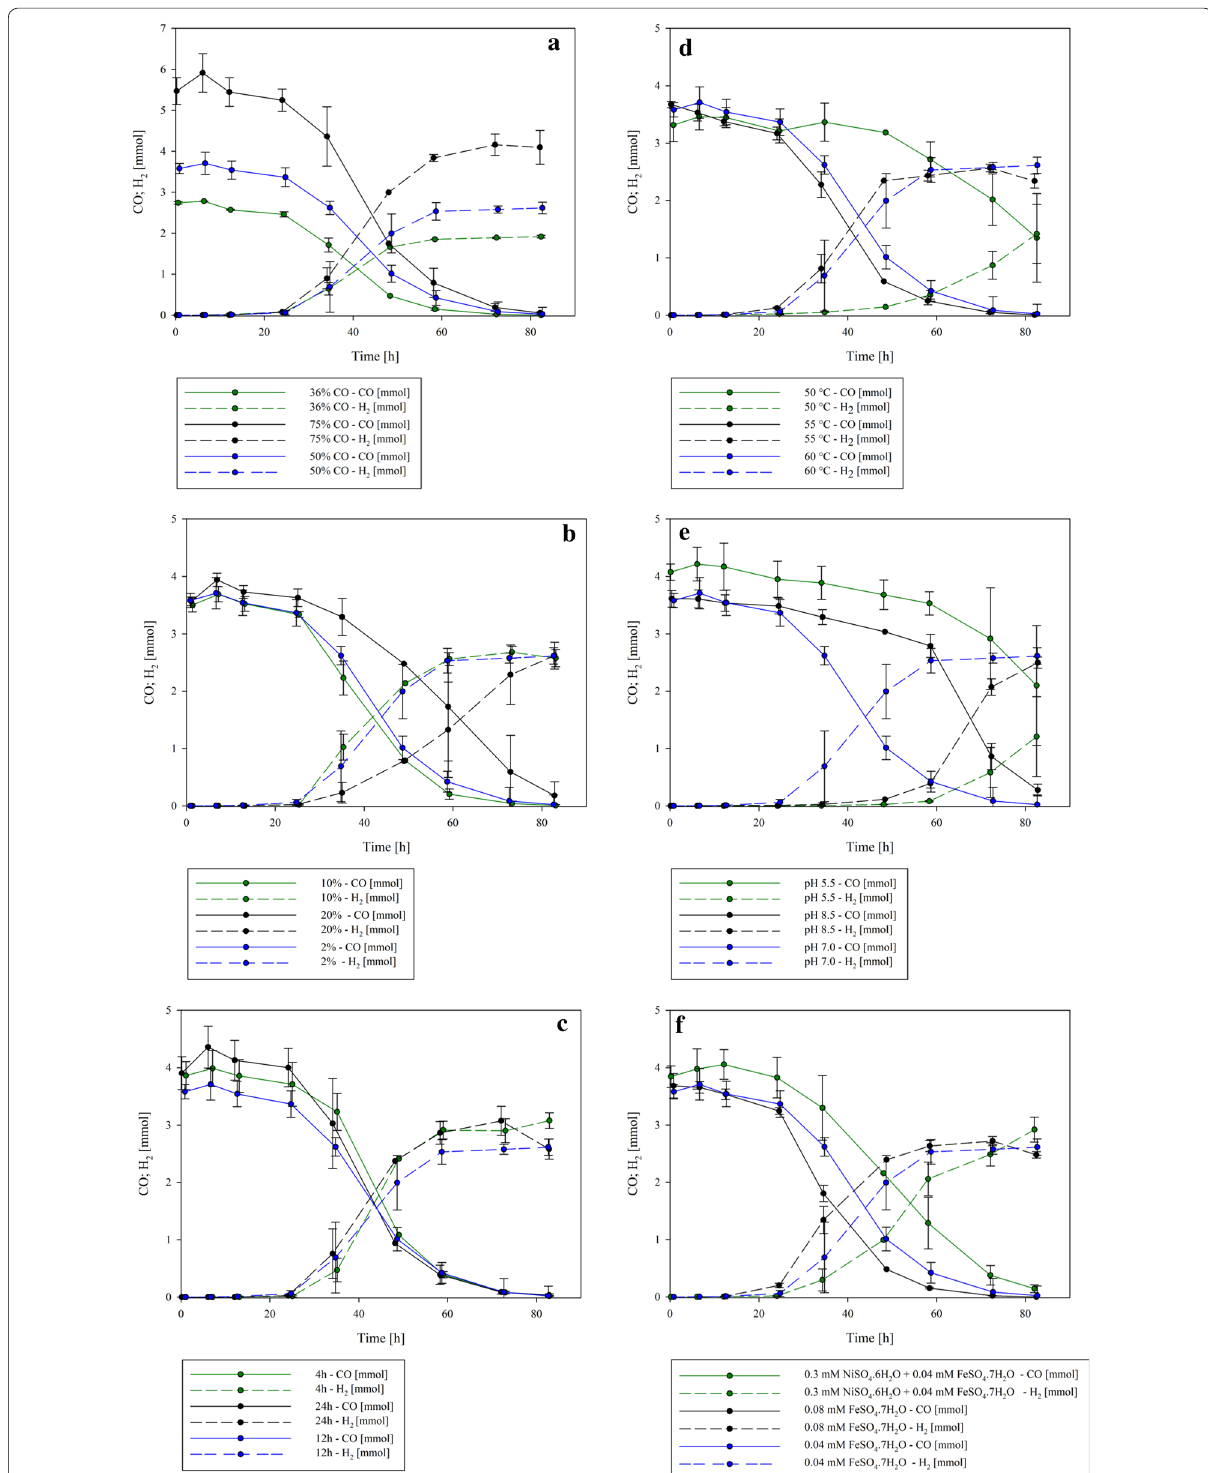
Fig. 2 Effects of several operating parameters on CO consumption and H 2 production during the cultivation of P. thermoglucosidasius . a Initial gas composition, b inoculum size, c age of 2nd pre-culture, d temperature, e initial pH and f addition of FeSO